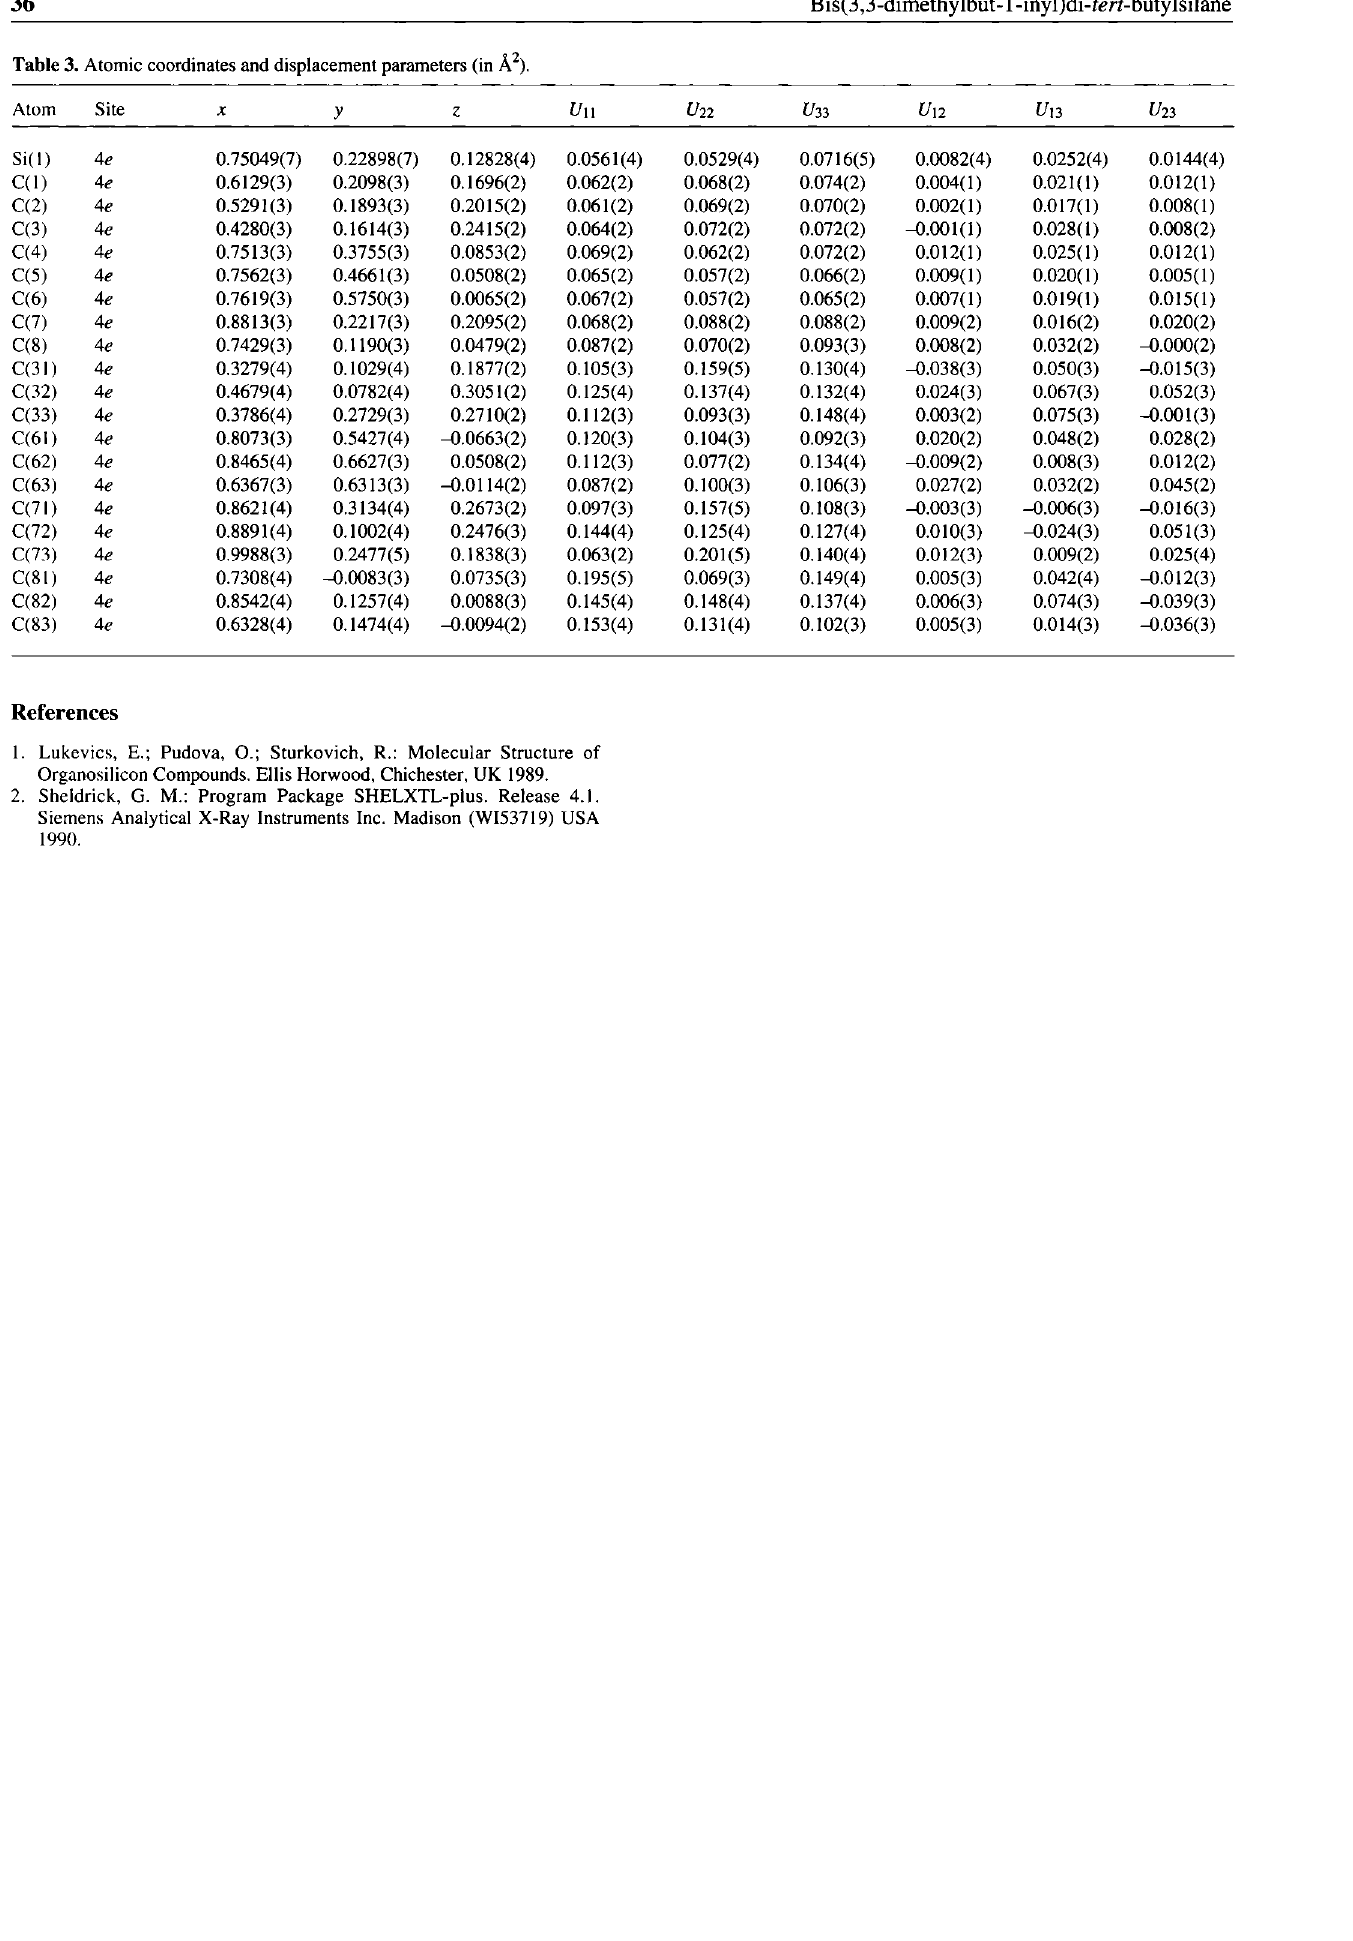
Table 3. Atomic coordinates and displacement parameters (in Ä 2 ).